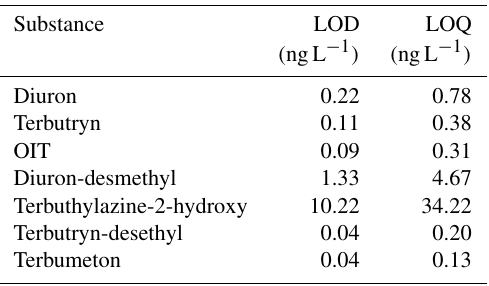
Table 2. LOD and LOQ of investigated substances with an enrich- ment factor of 4500 in surface